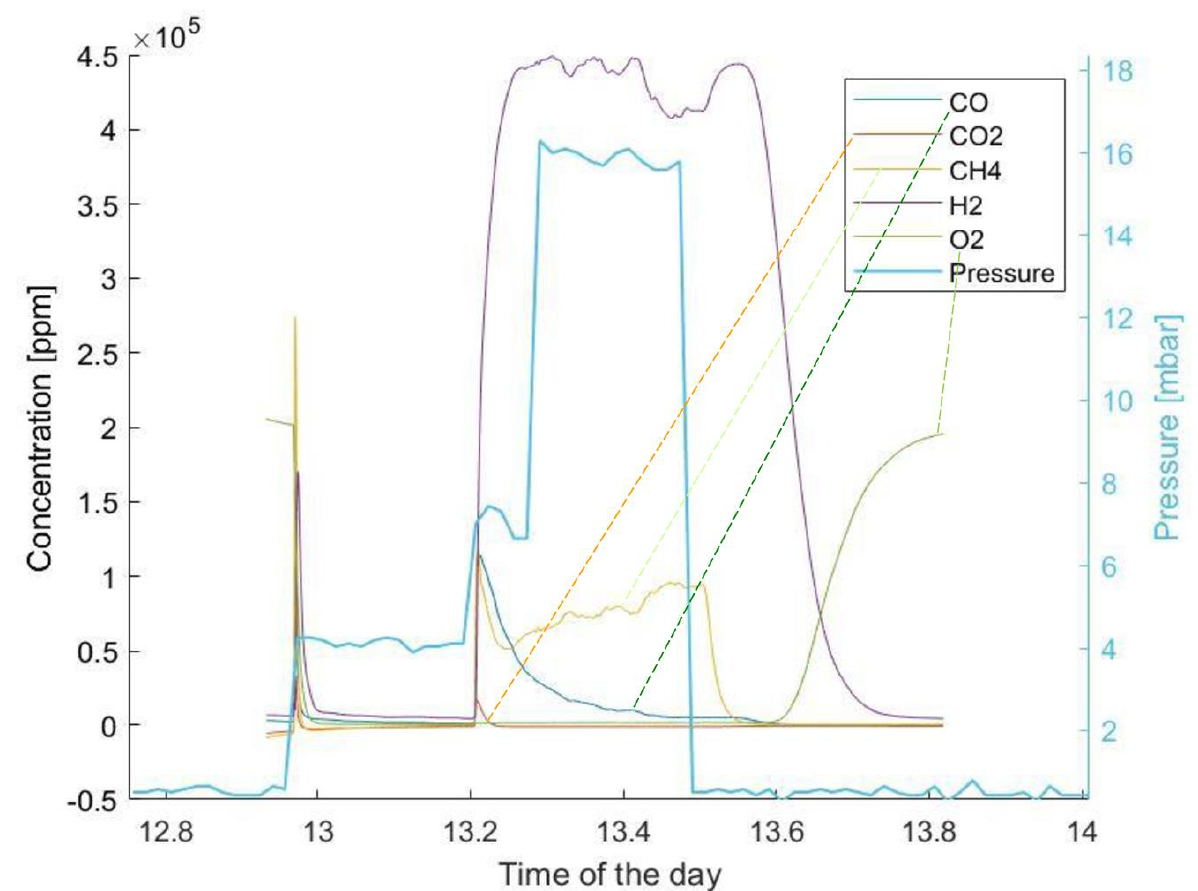
Figure 3. ppm(v) concentration of the gaseous mixture outflowing the reactor during test #3. Figure 4 plotted simulated and experimental gas concentrations. The order of